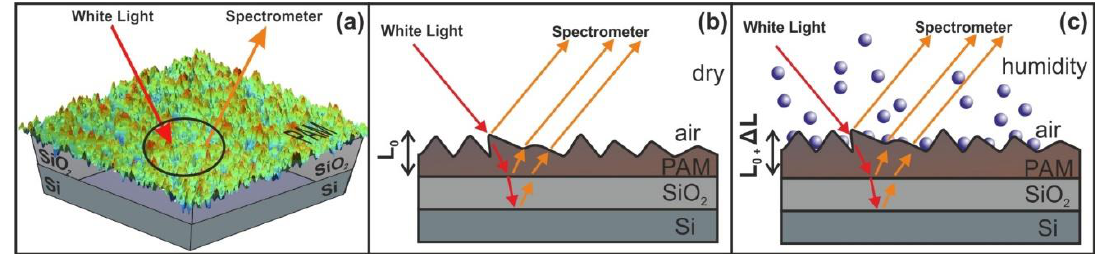
Figure 9. Principle of operation of white light reflectance spectroscopy (WLRS). ( a ) White light beam reflection in PAM surfaces. ( b ) experimental details and geometry of the reflected beams ( c ) surface strain response during water confinement in nanocavities. The contribution of the SiO 2 layer at the interference pattern is negligible.